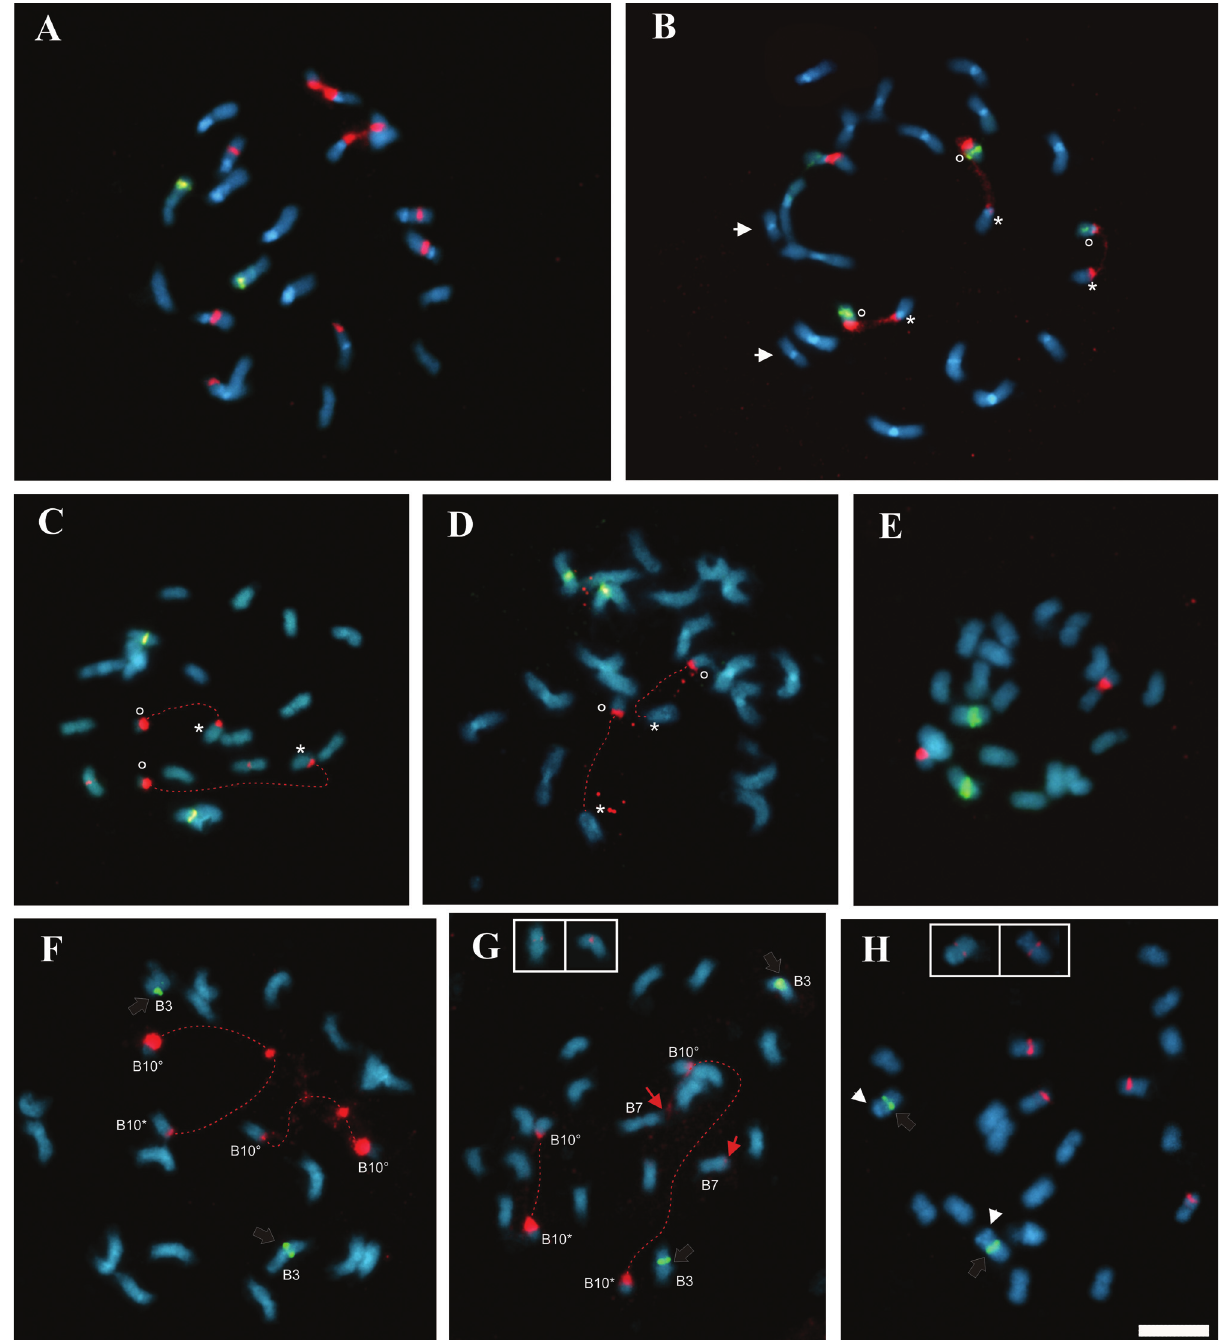
Figure 1 - Somatic metaphases of Brazilian accessions of Arachis , sect. Arachis , after heterochromatin detection and double fluorescence in situ hybrid- ization (FISH) of the rDNA genes. (A) A. glandulifera (14730), (B) A. hoehnei (V 9146), (C) A. gregoryi (V 14743), (D) A. gregoryi (V 6389), (E) A. gregoryi (V 14957), (F) A. magna (V 13765), (G) A. magna (V 14724) and (H) A. valida (V 13514). Yellow-green fluorescein isothiocyanate (FITC) sig- nals on the chromosomes correspond to the 5S rDNA probe and red tetramethyl-rhodamine isothiocyanate (TRITC) signals to the 45S rDNA probe. DAPIcounterstaining(lightblue)subsequenttoFISHwasusedtohighlighttheheterochromatinbandsandtostaineuchromatin.TheletterBfollowedby numbers (in F and G) indicates possible homeologies between the A. magna accessions studied here with the chromosomes of A. ipaënsis . In (H), B10 re- ferstothecorrespondingchromosomalpairofpreviouslystudiedaccessionsof A.valida .Inthecasesinwhichthesecondaryconstrictionisextended,the short arm and the proximal segment of the long arm are indicated by an asterisk and the separated satellite is marked by a degree sign. The satellites and their proximal segments are linked by a dashed red line. White arrows (in B) indicate the small metacentric pair of chromosomes. Red arrows (in G) indi- cate telomeric 45S rDNA loci. Empty arrows (in F, G and H) show the sites at which 5S and 45S rDNA co-localize. Inserts in G and H correspond to the chromosomes in which the 5S and 45S rDNA co-localize, with the hybridization of the 45S loci in red. White arrowheads (in H) indicate distal heterochromatic bands. Scale bar = 5 (cid:2)